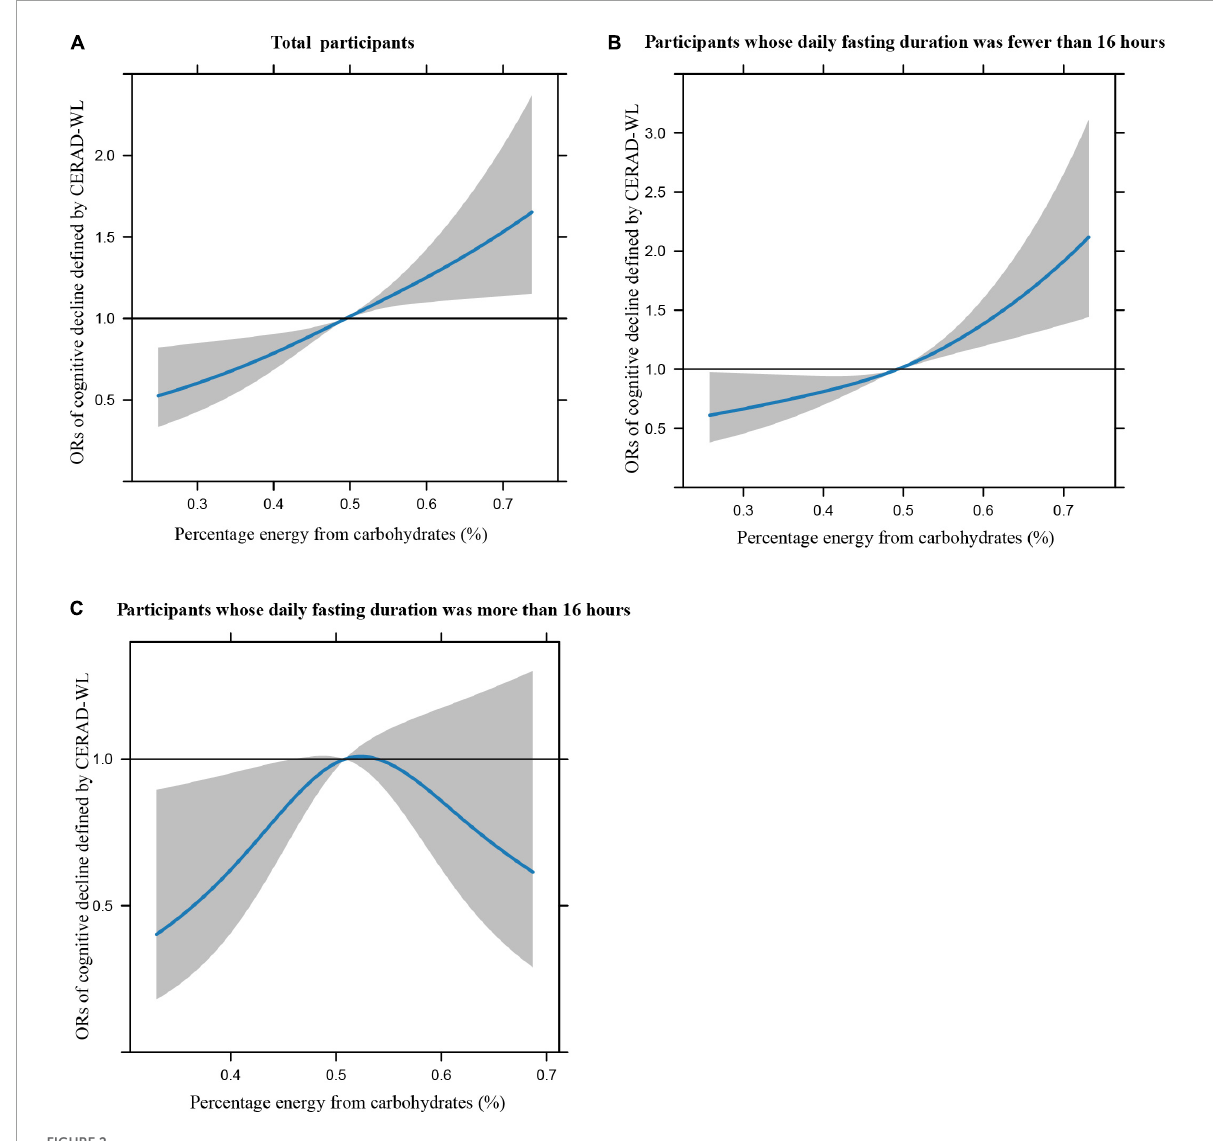
FIGURE2 Restricted cubic splines between percentage energy from carbohydrates (%) and poor cognitive performance of